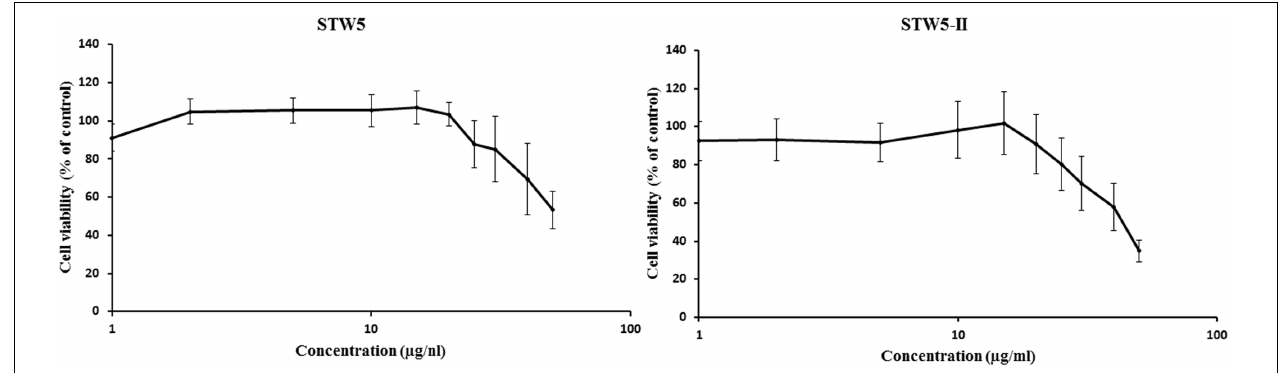
FIGURE 1 | Cytotoxic effects of STW5 and STW5-II: NCM460 cells were treated with STW5 or STW5-II for 24 h. Cytotoxicity was measured by resazurin assays by normalizing to untreated control.